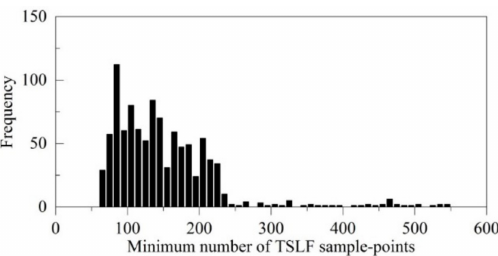
Figure 7. The frequency distribution for 1000 simulations of the minimum number of TSLF sample-points required to estimate FC MA with an ADMM of 10% when using the TSLF map for a 2100 × 2100 grid simulated landscape that included all 1200 fire-year maps. The minimum number of TSLF sample-points is 65, median is 147, the 95th percentile is 239, and maximum is 571.